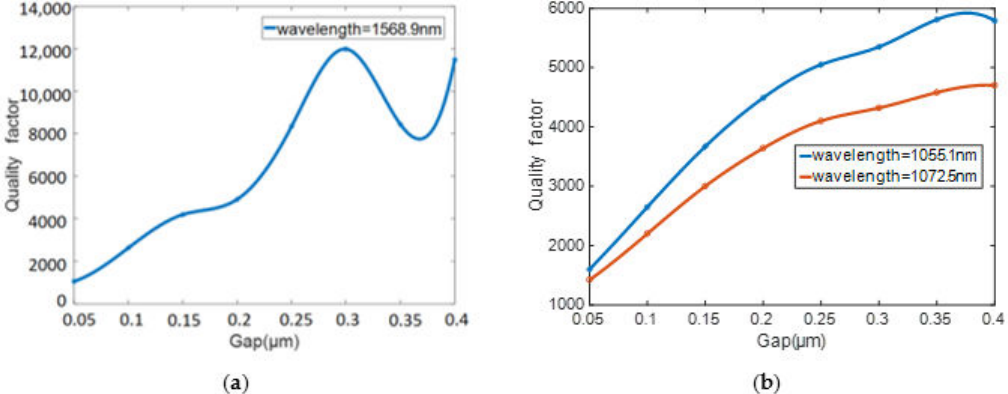
Figure 7. Relationship between the Q value and coupling gap. ( a ) silicon. ( b ) silicon nitride.